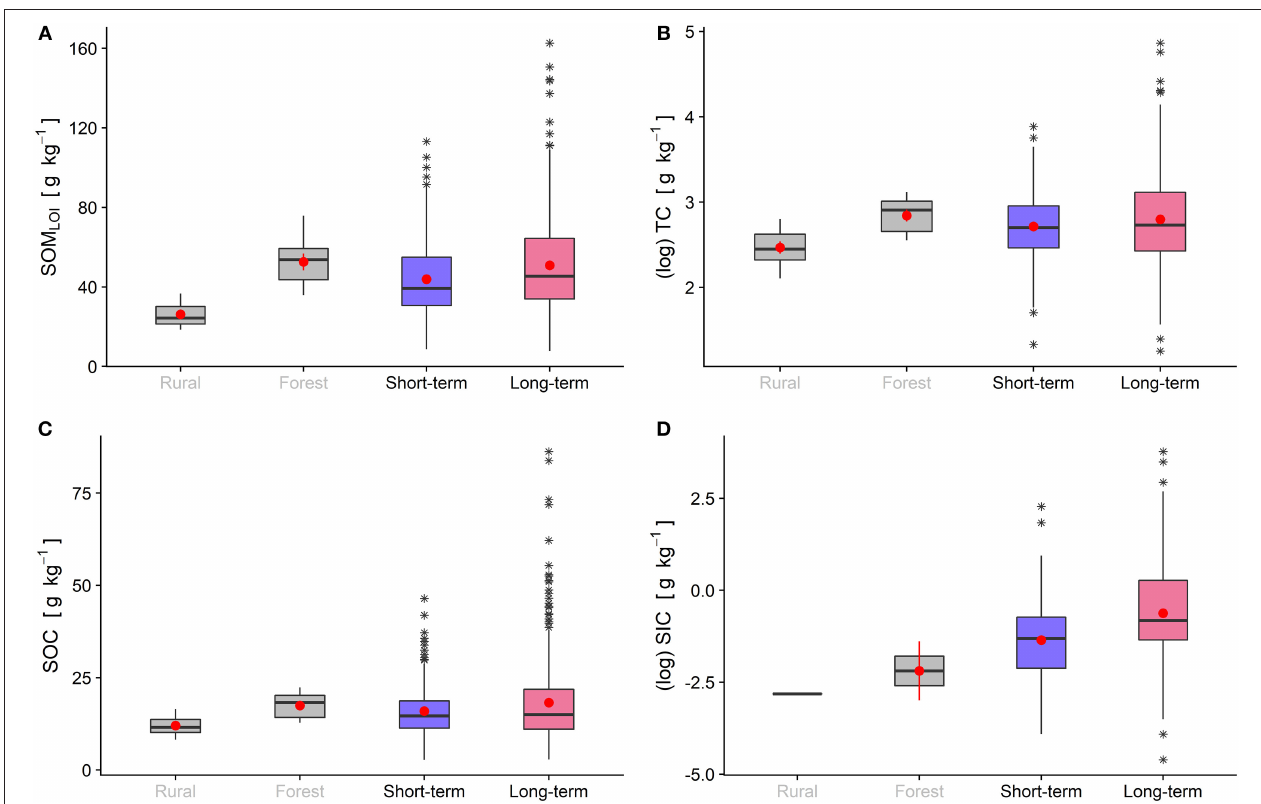
FIGURE 6 | Boxplots comparing rural, forest and urban soils with respect to fine earth contents of (A) SOM LOI , soil organic matter obtained from loss on ignition; (B) TC, total carbon; (C) SOC, soil organic carbon; (D) SIC, soil inorganic carbon. Arithmetic means (red points), standard errors (red whiskers), medians (bars), ranges (whiskers), and outliers (asterisks) are